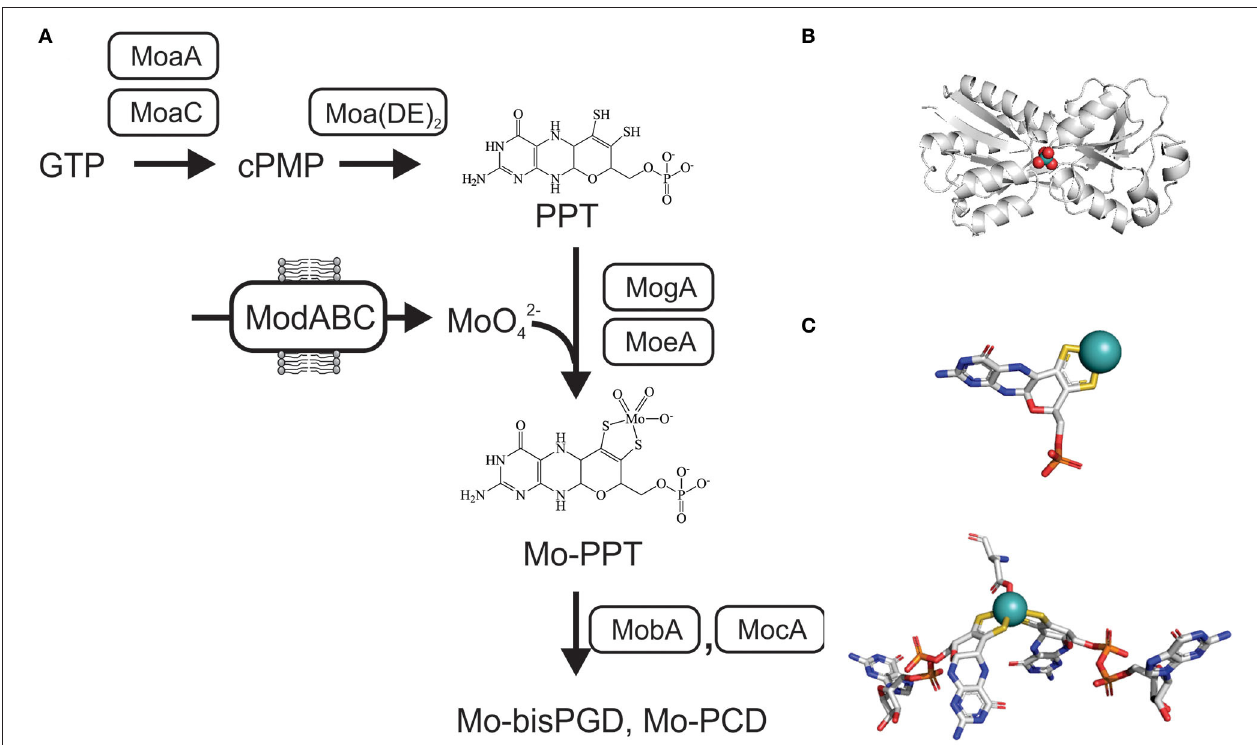
FIGURE 2 | Schematic representation of the biosynthesis of Mo-PPT and Mo-PPT-dinucleotide forms from GTP/CTP in bacteria. cPMP, cyclic pyranopterin monophosphate; PPT, pyranopterin; PGD/PCD, pyranopterin guanine/cytosine dinucleotide; (MoaDE) 2 , PPT synthase. (A) Overview over molybdate uptake and Mo-PPT biosynthesis (B) Crystal structure of ModA from Escherichia (PDB: 1AMF) with a molybdate ion (MoO − 4 ) bound, bluewhite- protein backbone, teal– molybdenum, red– oxygen. (C) 3D conformations of Mo-PPT and Mo-bisPGD in the enzyme-bound form, Mo-PPT is from MsrP (PDB: 1XDQ), Mo-bisPGD – NarGH (PDB: 1R27). Colors: white – carbon, blue – nitrogen, orange – phosphor, red – oxygen, yellow – sulfur, light teal–